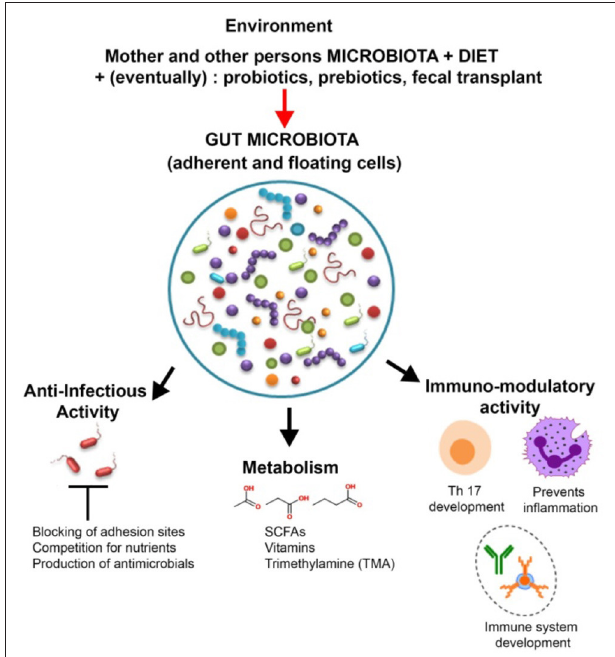
FIGURE 2 | Roles and modulation of gut microbiota. In addition to helping digestion and synthesizing vitamins and other metabolites, such as short-chain fatty acids (SCFAs), the members of the gut microbiota play an important role in host defense (by producing antimicrobial compounds and competing against pathogens for adhesion sites and nutrients) as well as in the development and training of the immune system. The gut microbiota is influenced by a wide array of factors such as diet, probiotics, and